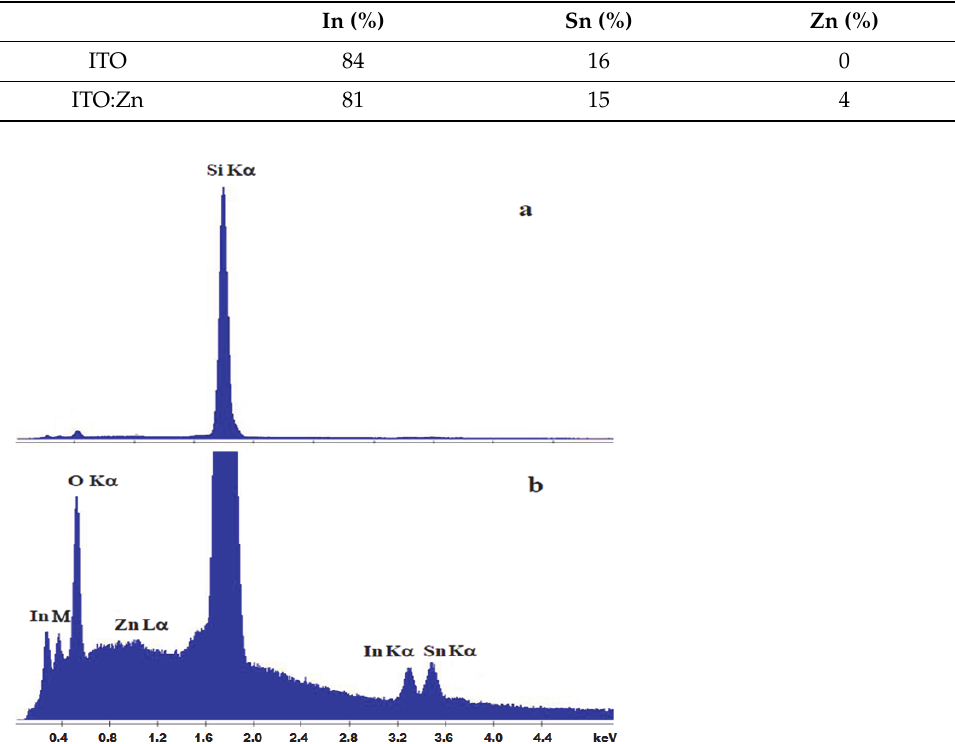
Table 1. Cationic elemental composition (Sn, In, and Zn) (at.%) of the films deposited on Si.